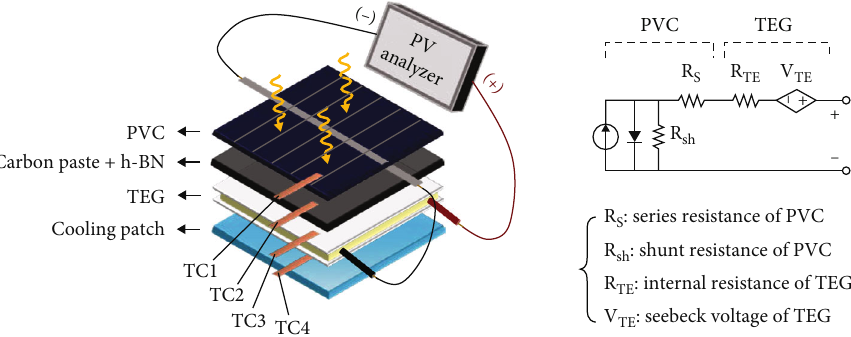
Figure 1: Schematic and circuit diagrams of a HED with a cooling